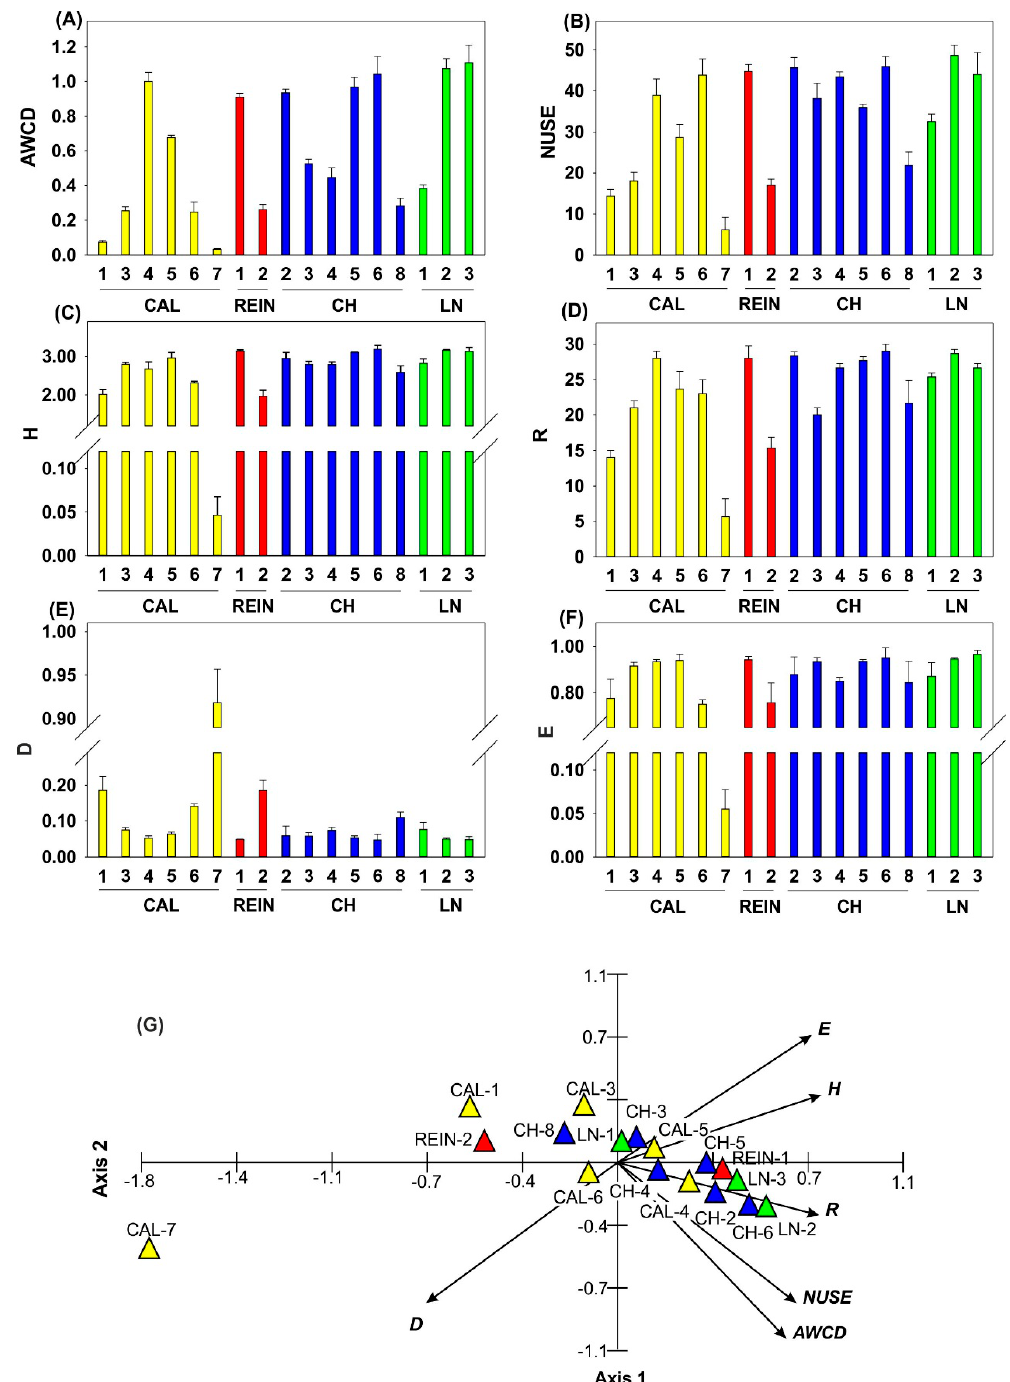
Figure 4. Parameters describing the activity and catabolic diversity of the soil microbial communities: AWCD ( A ); NUSE (nitrogen use index) ( B ); H (Shannon's diversity index) ( C ); R (substrate richness) ( D ); D (domination index) ( E ); E (substrate evenness) ( F ). PCA for AWCD, NUSE, H, R, D, and E ( G ).